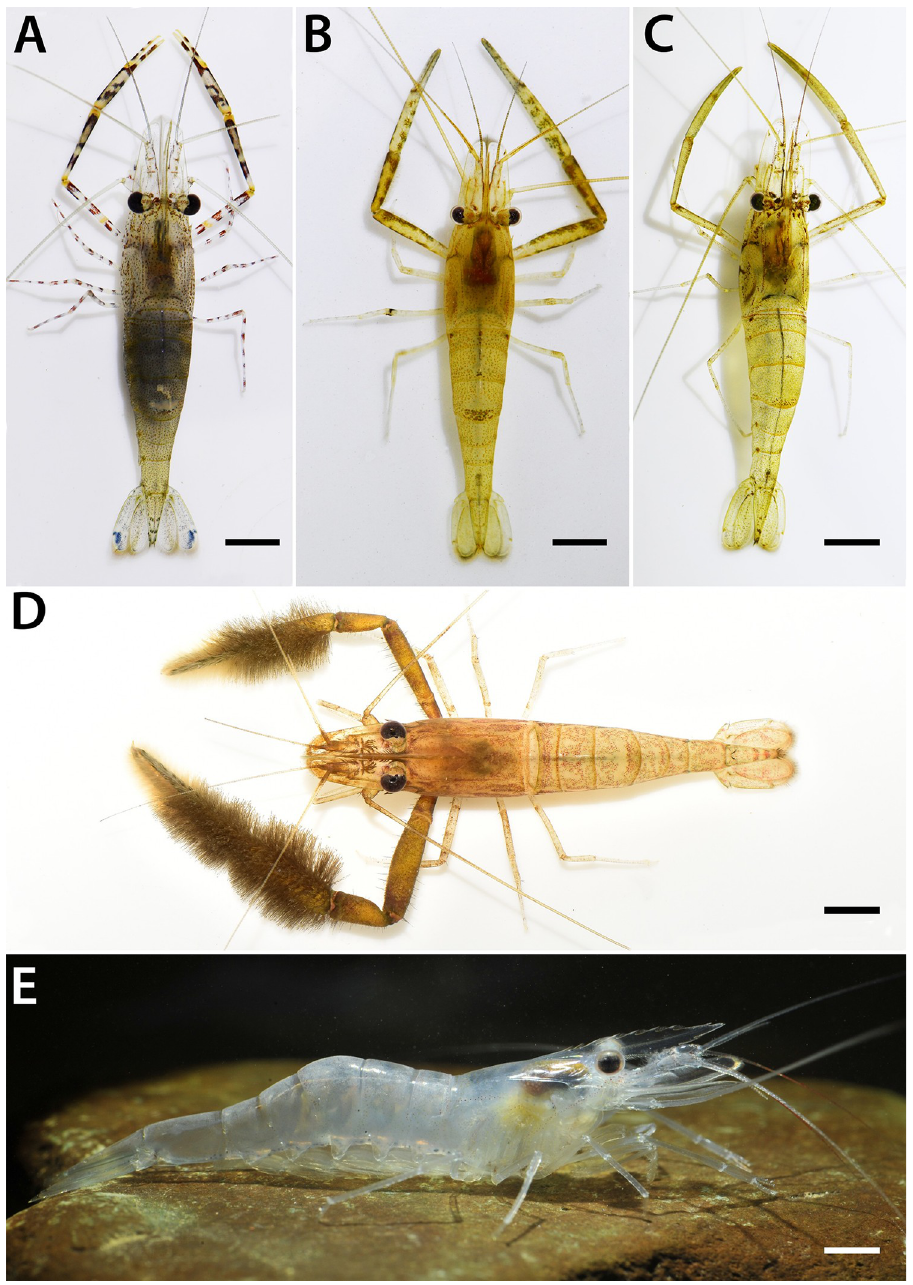
Fig 2. Representative morphology and live habitus coloration of five common Macrobrachium species; A. M . equidens B. M . niphanae C. M . sintangense D. M . dienbienphuense and E. M . lanchesteri . Approximate size shown in scale bar (5